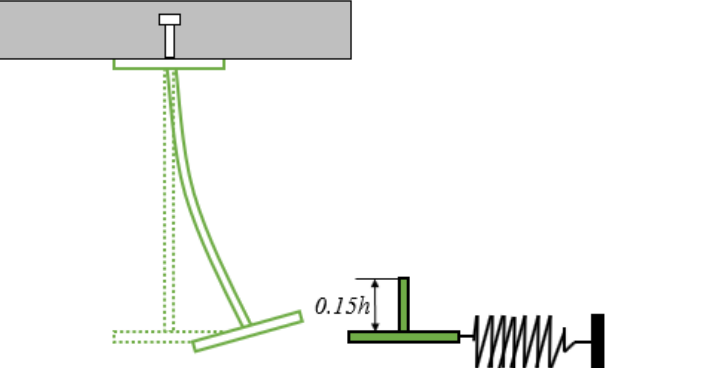
Figure 11. Williams and Jemah [122] model. Adapted from Williams and Jemah [122].